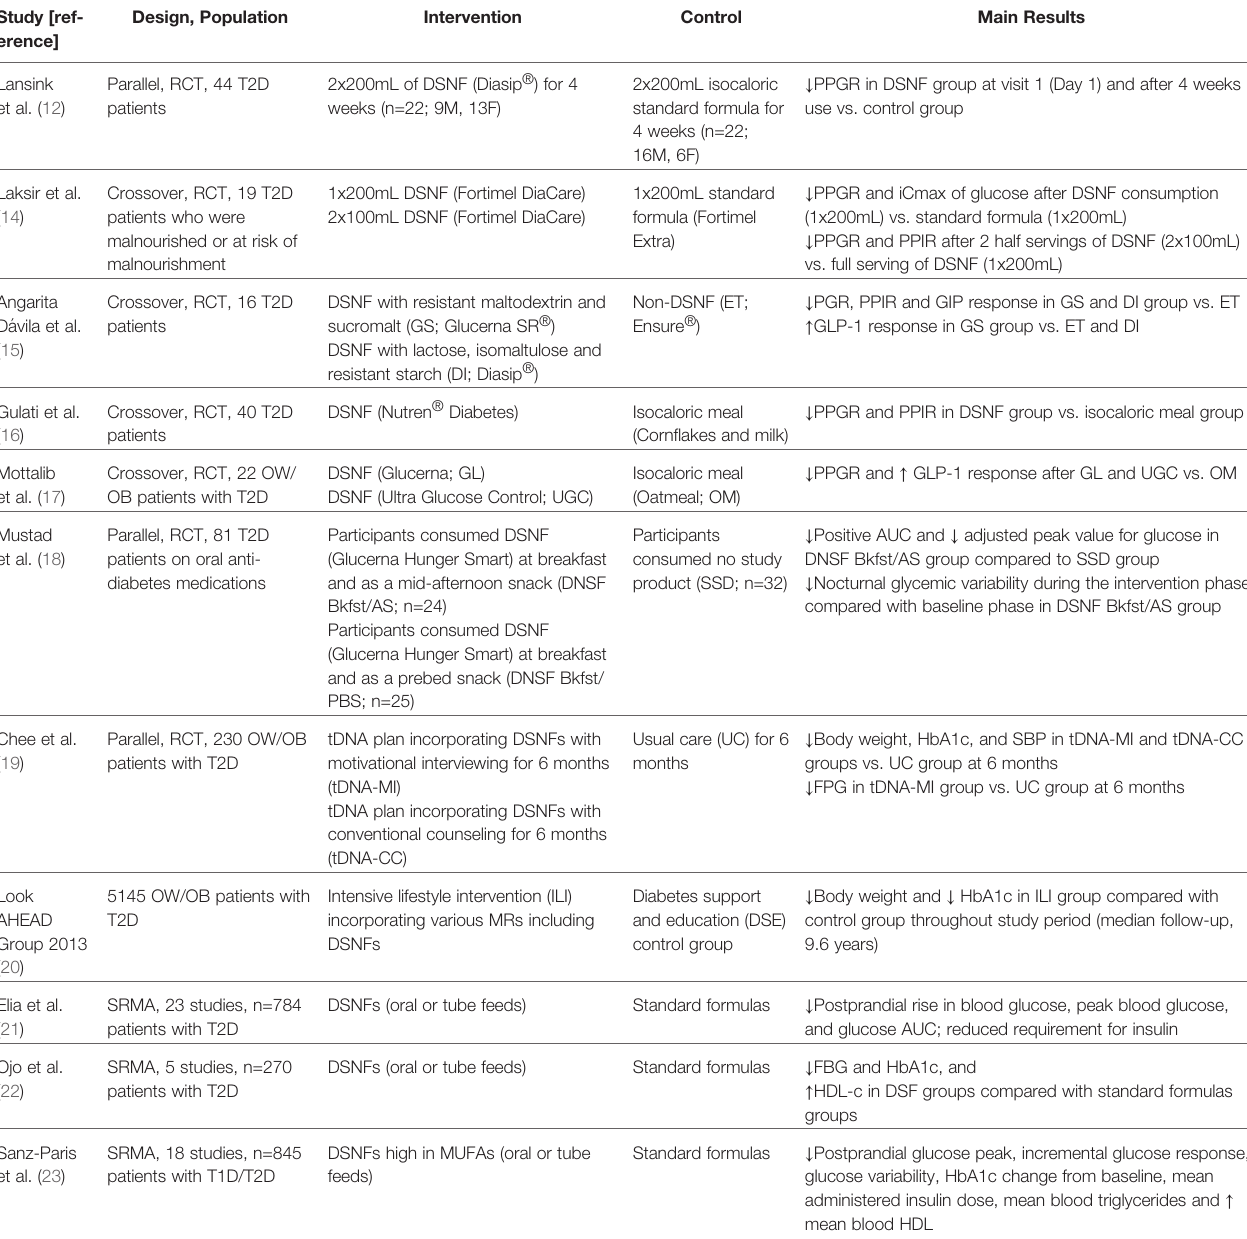
TABLE 1 | Effect of Diabetes-Speci fi c Nutrition Formulas on Glycemic and Cardiometabolic Endpoints in Patients with Type 2 Diabetes. Study [ref- Design, Population Intervention Control Main Results erence] Parallel, RCT, 44 T2D